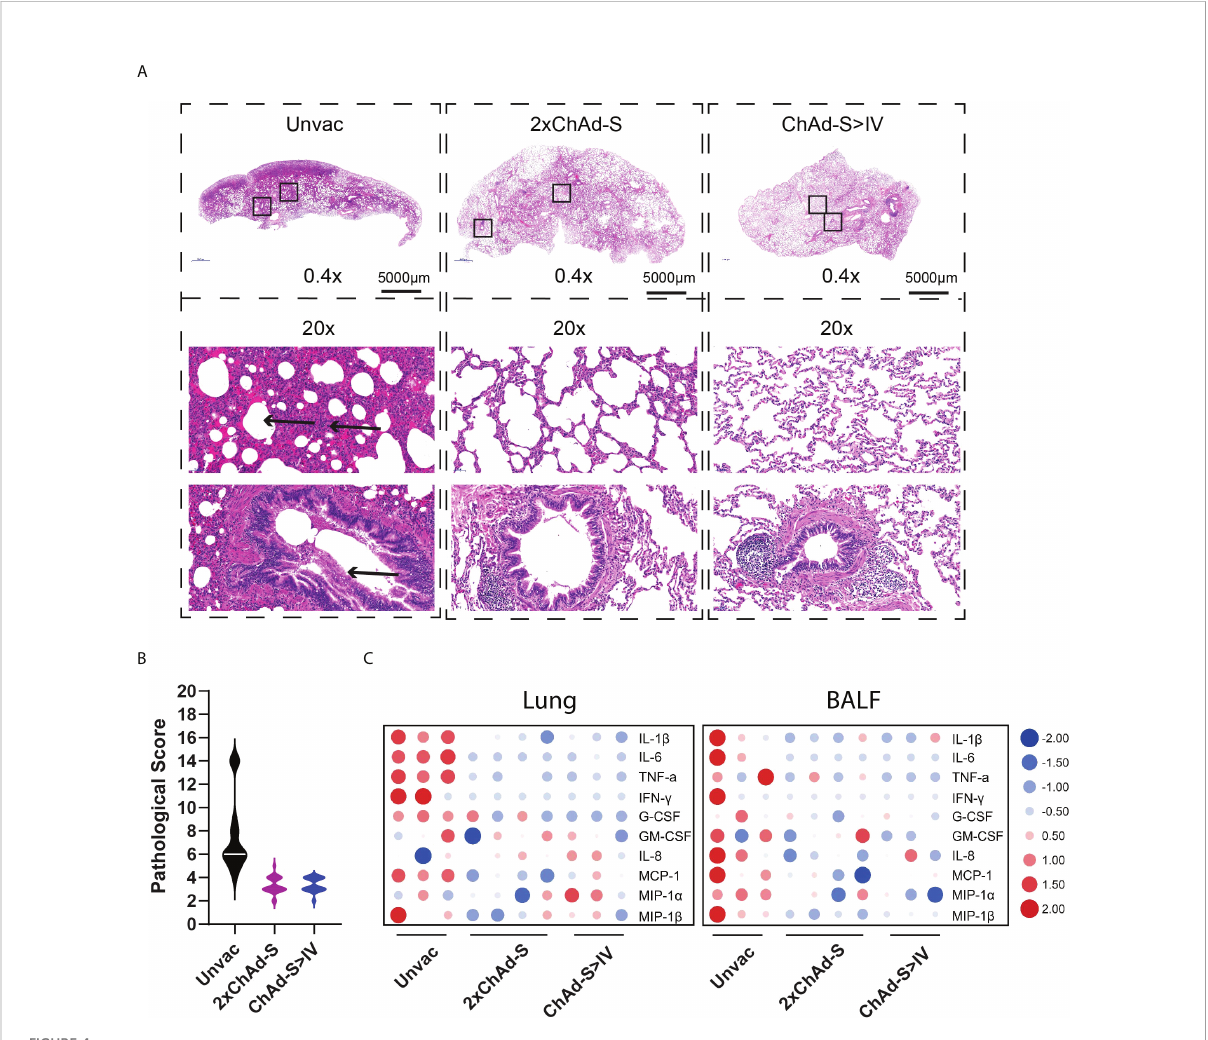
FIGURE 4 Pulmonary histopathology and in fl ammatory cytokine analysis of NHPs after challenge. (A) Representative graph of hematoxylin and eosin (H&E) staining of lung tissues. Arrowhead indicates the histopathological lesion. (B) Pathological score of all lung lobes of each macaque (18 specimens for each group) was counted according to the severity and extent of histopathological lesion and represented as violin plot. (C) The concentrations of multiple in fl ammatory cytokines in lung homogenate (left panel) and BALs (right panel) in different groups were compared using heatmap. The concentration of each cytokine was transformed by log2 and normalized by